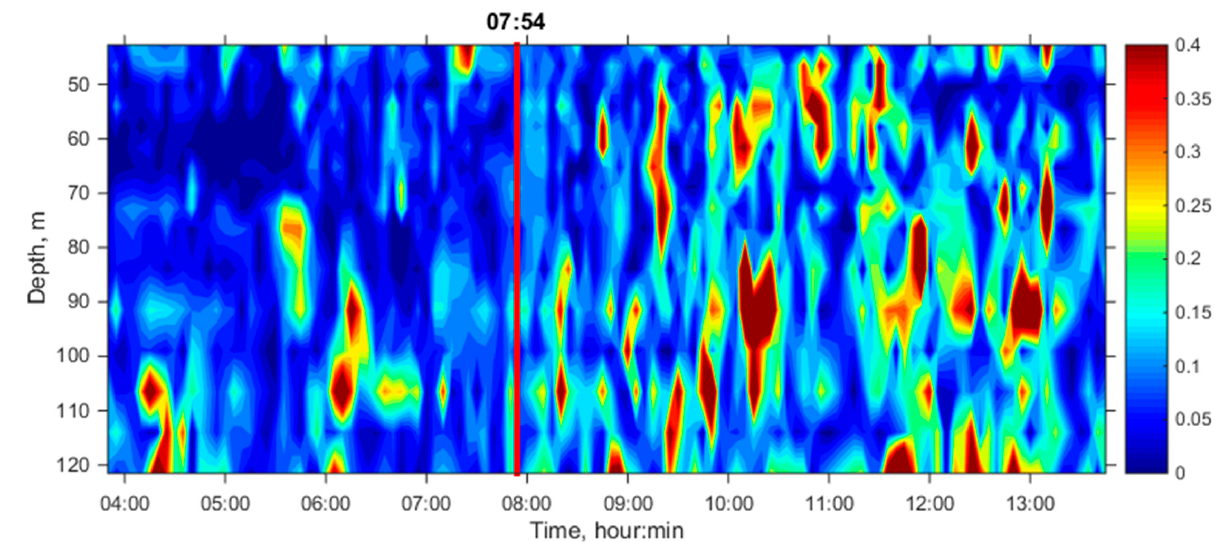
Figure 9. Amplitude of intensity fluctuations as a function of depth and time. The red line denotes the time moment of appearance of the soliton on the acoustic track (07:54).